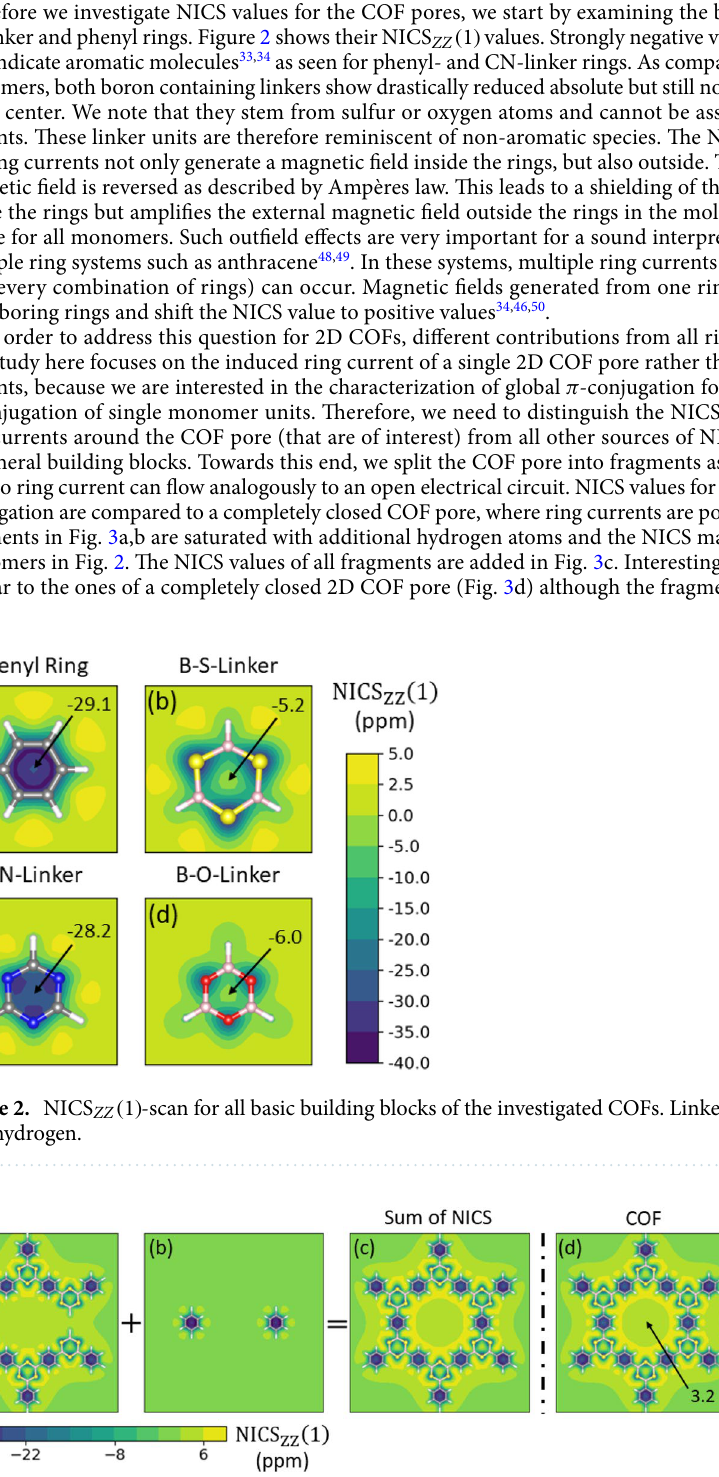
Figure 3. NICS ZZ ( 1 ) -scans ( 1 Å above the molecular plane) for a single pore of COF-BS-1Ph. ( a – c ) The decomposition scheme that is compared with calculations of the entire pore ( d ). All other investigated COFs show similar